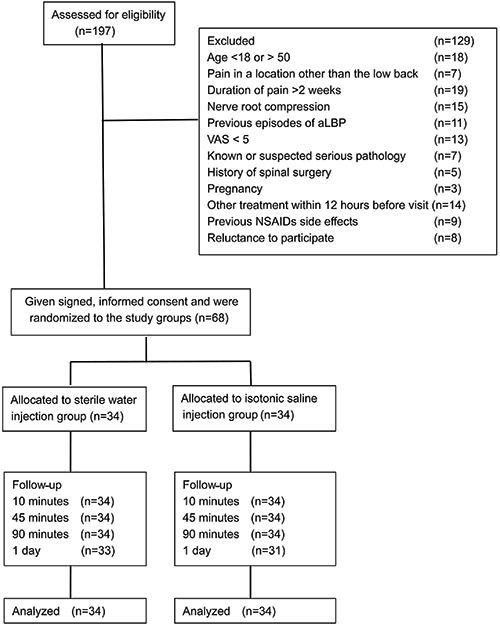
Study flow chart.